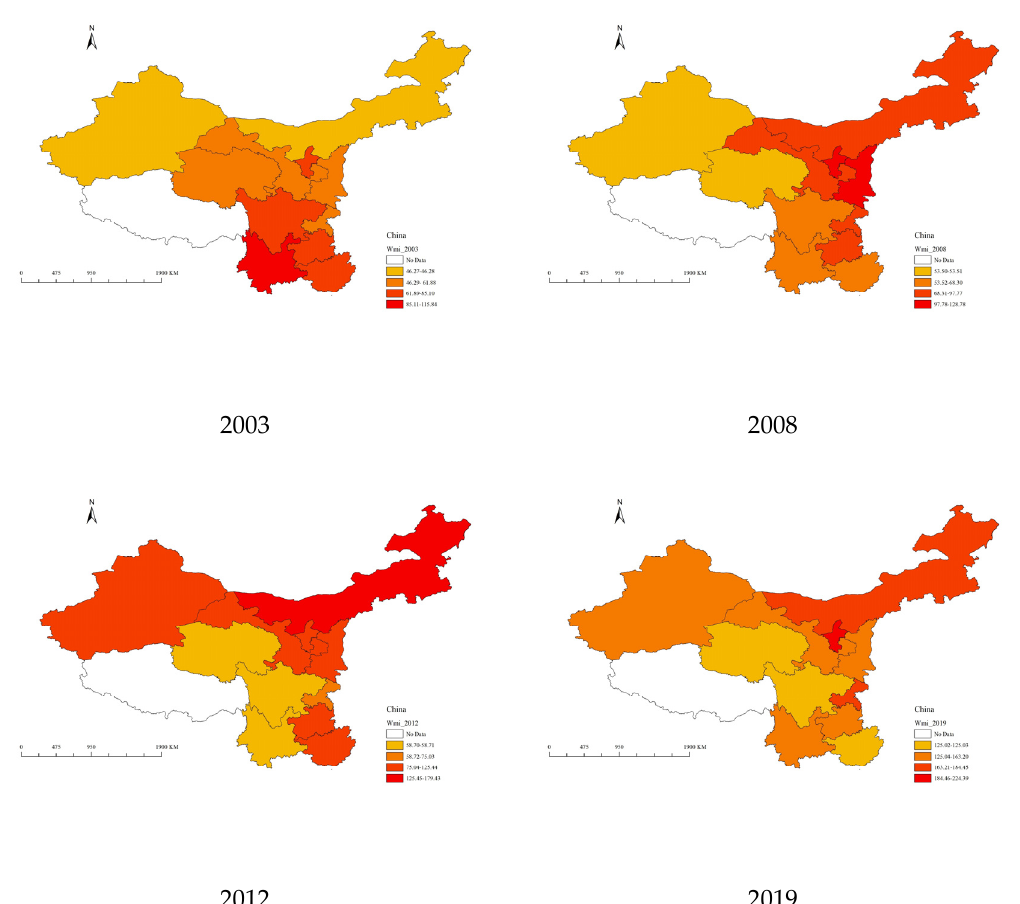
Figure 4. The level of market integration in western China.